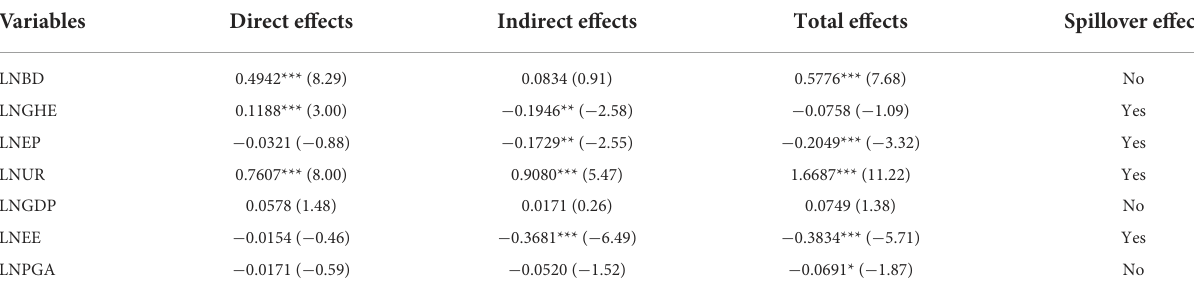
TABLE 7 Direct, indirect, and total effects of independent variables on